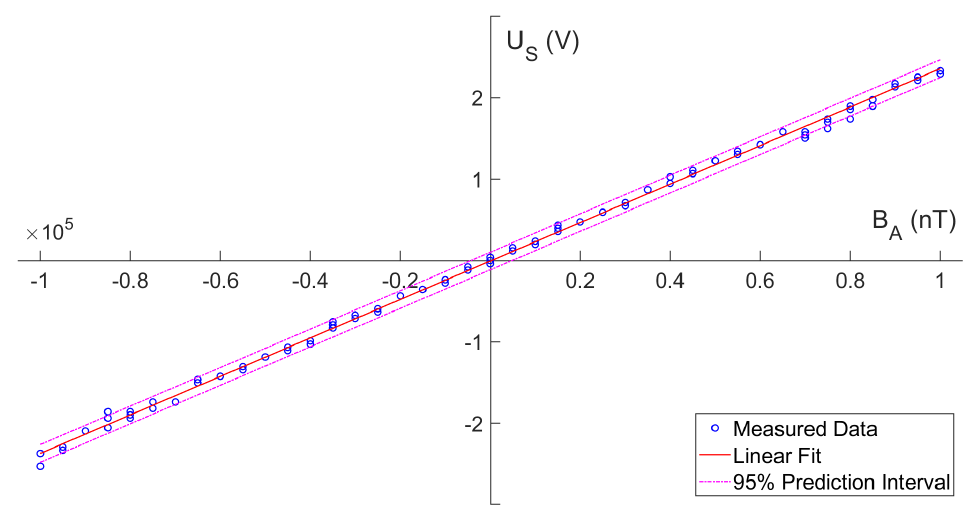
Figure 9. The output voltage U S versus the applied DC magnetic field B A . The linear fitting curve is shown in red line. The 95% prediction interval is shown in magenta dotted lines.